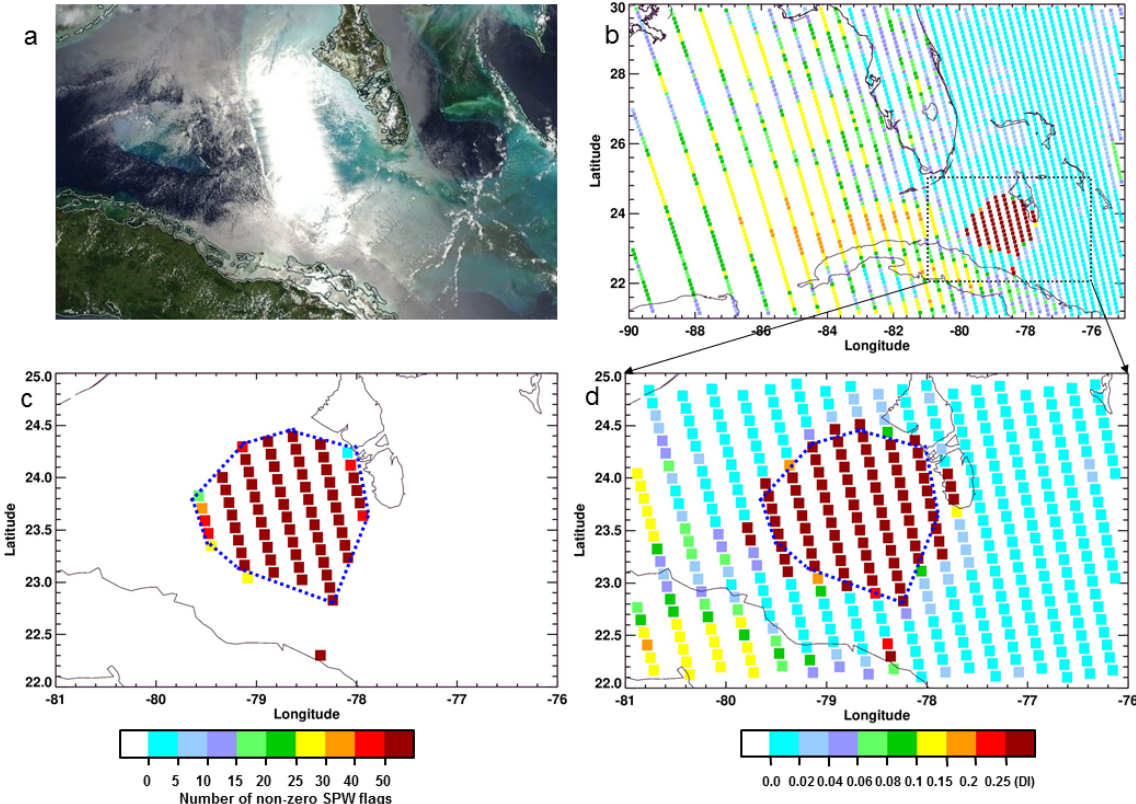
Figure 7. Similar to Fig. 1 but for an area showing solar glint near the Bahamas (orbit 48034, 26 July 2013). Glint positions in panels (c) and (d) do not exactly match those in the RGB image (a) . The area of pixels marked by the SPW flags are approximately delineated by the dotted blue